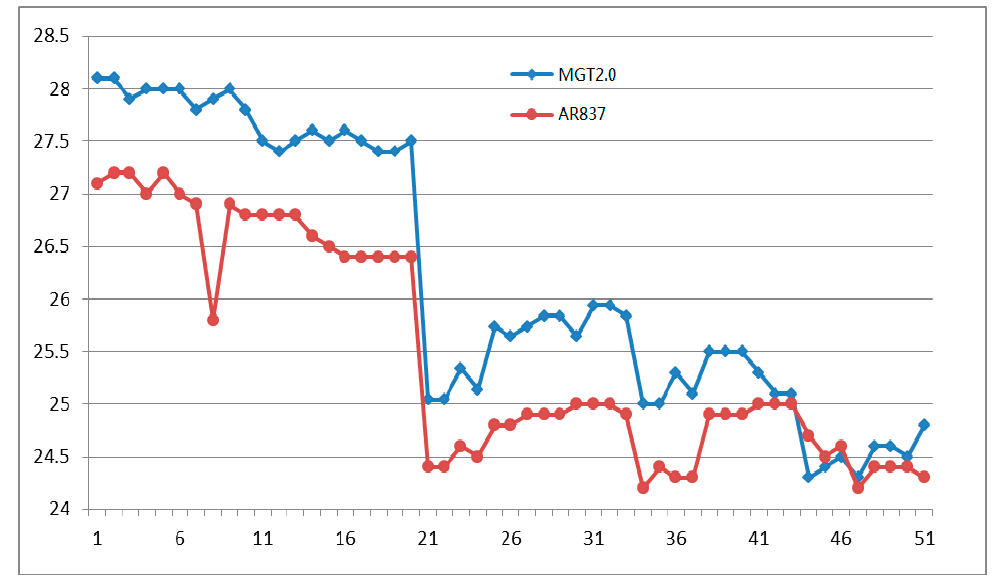
Figure 11. Fifty air temperature ( ◦ C) experimental results by MGT2.0 (marked by blue line) and AR837 (marked by red line).